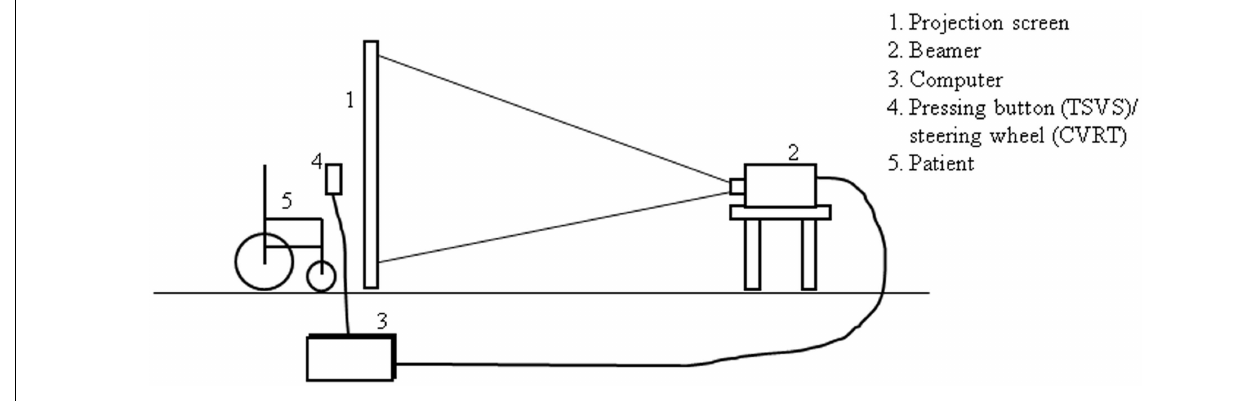
FIGURE 1 |TSVS visual scanning training set-up .